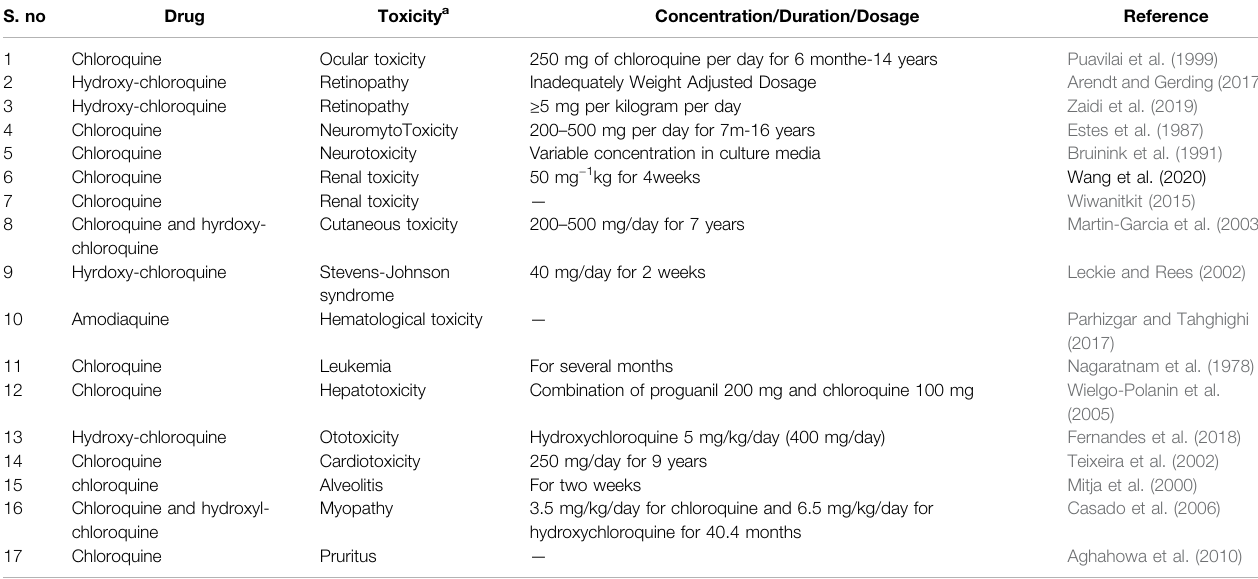
TABLE 4 | Toxic effects of